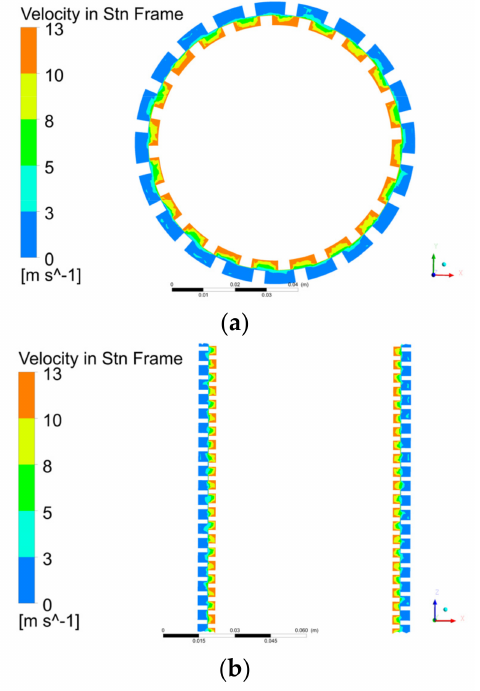
Figure 7. Contours of fluid speed distribution in the pump on the ( a ) XY and ( b ) XZ